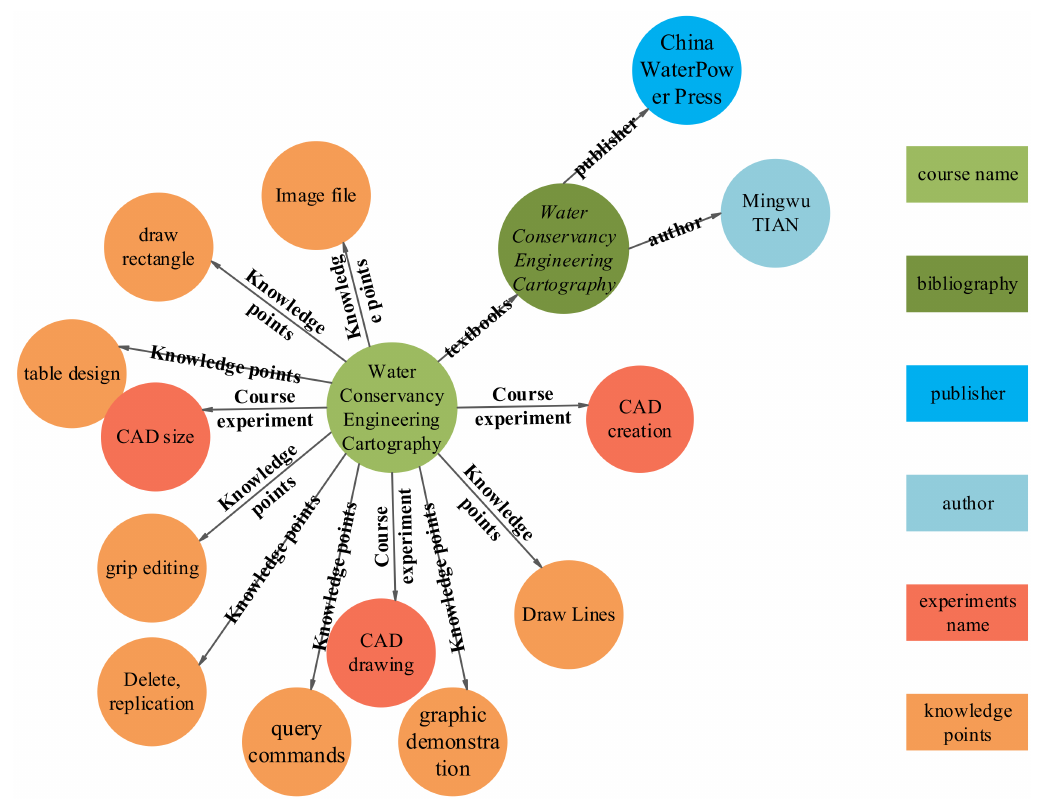
Figure 6. Illustration of Course Information Query